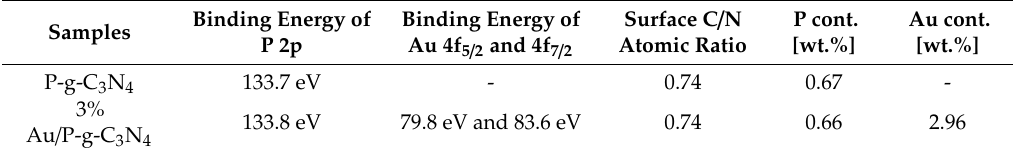
Figure 2. XPS survey spectra of P-g-C 3 N 4 ( a ) and 3% Au / P-g-C 3 N 4 ( b ), P 2p high-resolution spectrum ( c ) and Au 4f high-resolution spectrum ( d ) for 3% Au / P-g-C 3 N 4 . Table 1. XPS data obtained for P-g-C 3 N 4 and 3% Au / P-g-C 3 N 4 .